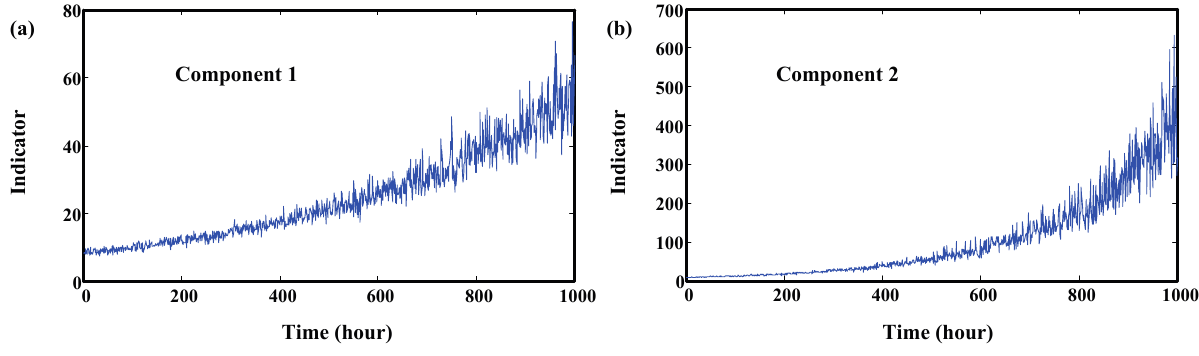
Figure 3. Simulated degradation indicators of two components. ( a ) Component 1; ( b ) Component 2.